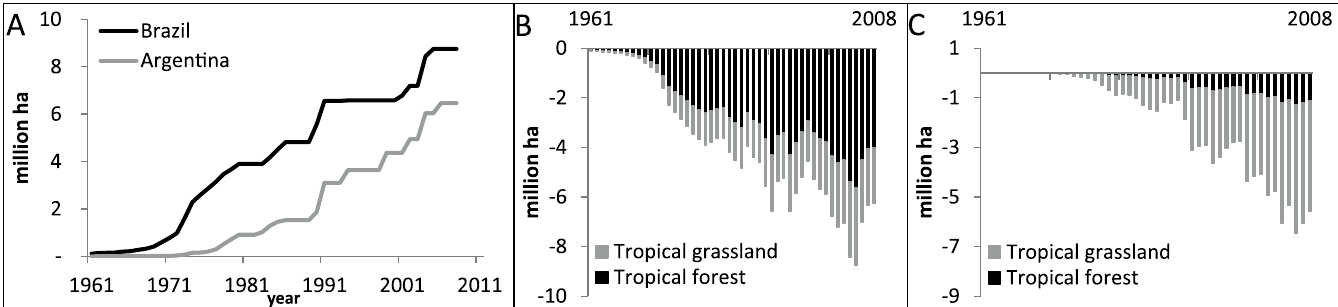
Fig 2. Land use changes in Brazil and Argentina due to increasing soybean import by Europe, 1961 – 2008: soybean area expansion in Brazil and Argentina for the export to Europe (A), corresponding changes in tropical grassland and forest in Brazil (B) and Argentina (C).